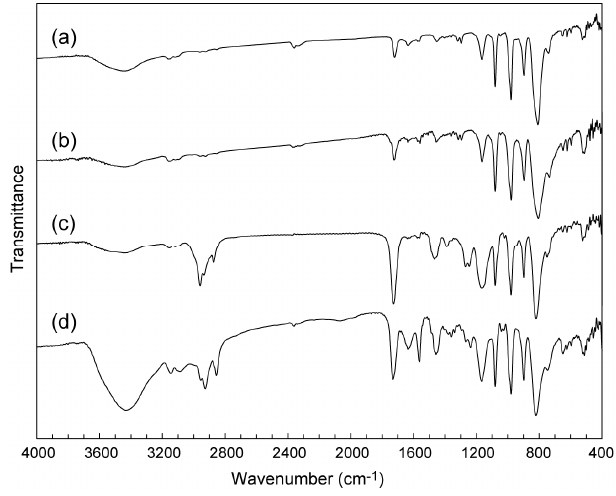
Figure 4. IR spectra of MAImC 1 -PW 12 hybrids: ( a ) MAImC 1 -PW 12 hybrid monomer; ( b ) P-MAImC 1 - PW 12 hybrid homopolymer by using DMF; ( c ) CP-MAImC 1 -PW 12 /BMA hybrid copolymer; and ( d ) CP-MAImC 1 -PW 12 /MAImC 8 Br hybrid copolymer.